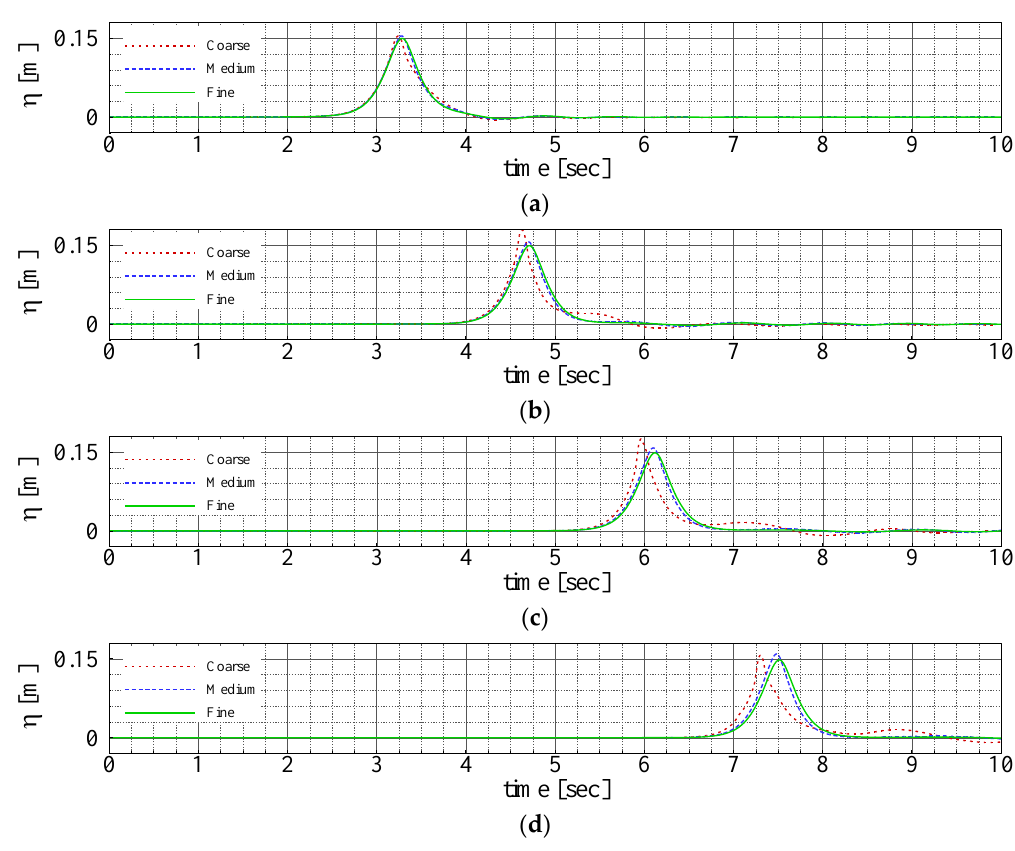
Figure 5. Grid dependency analysis. ( a ) x = 2 m; ( b ) x = 5 m; ( c ) x = 8 m; ( d ) x = 11 m. Table 2. RMSE of the grid dependency